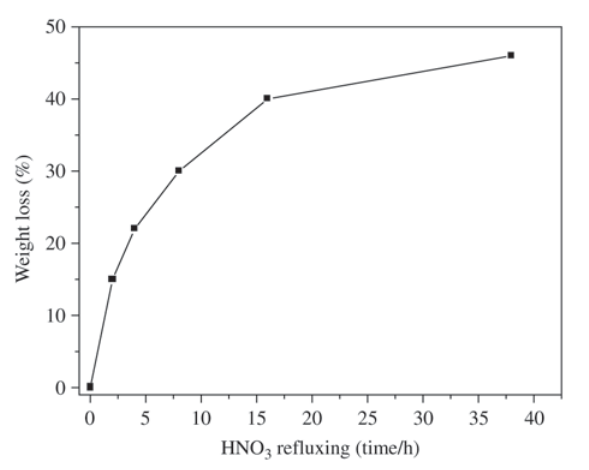
Figure 1. Weight losses after refluxing activated carbon with con- centrated HNO for different 3